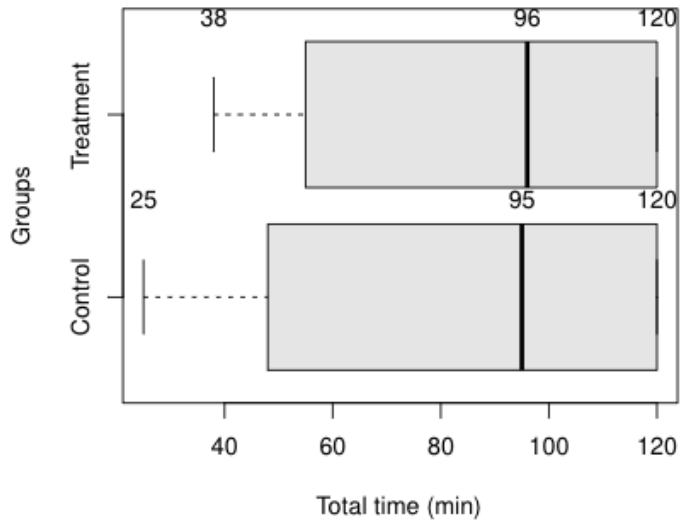
Figure 12. Time collected for the control and treatment group.